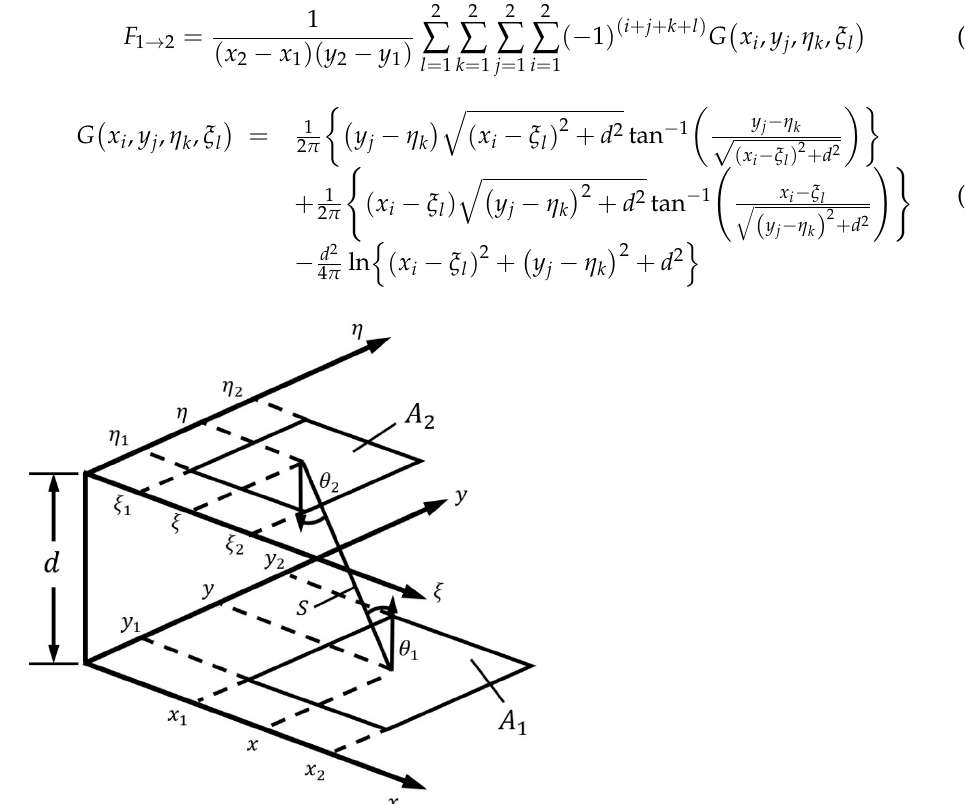
Figure 5. Plate arrangements (parallel plates) [32].